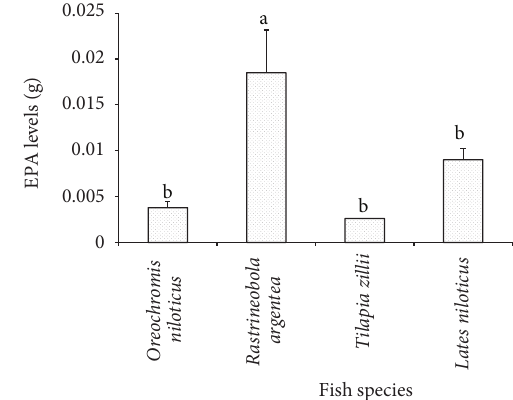
Table 2: Types of 𝜔 3 PUFAs found in each individual species. Type of FA